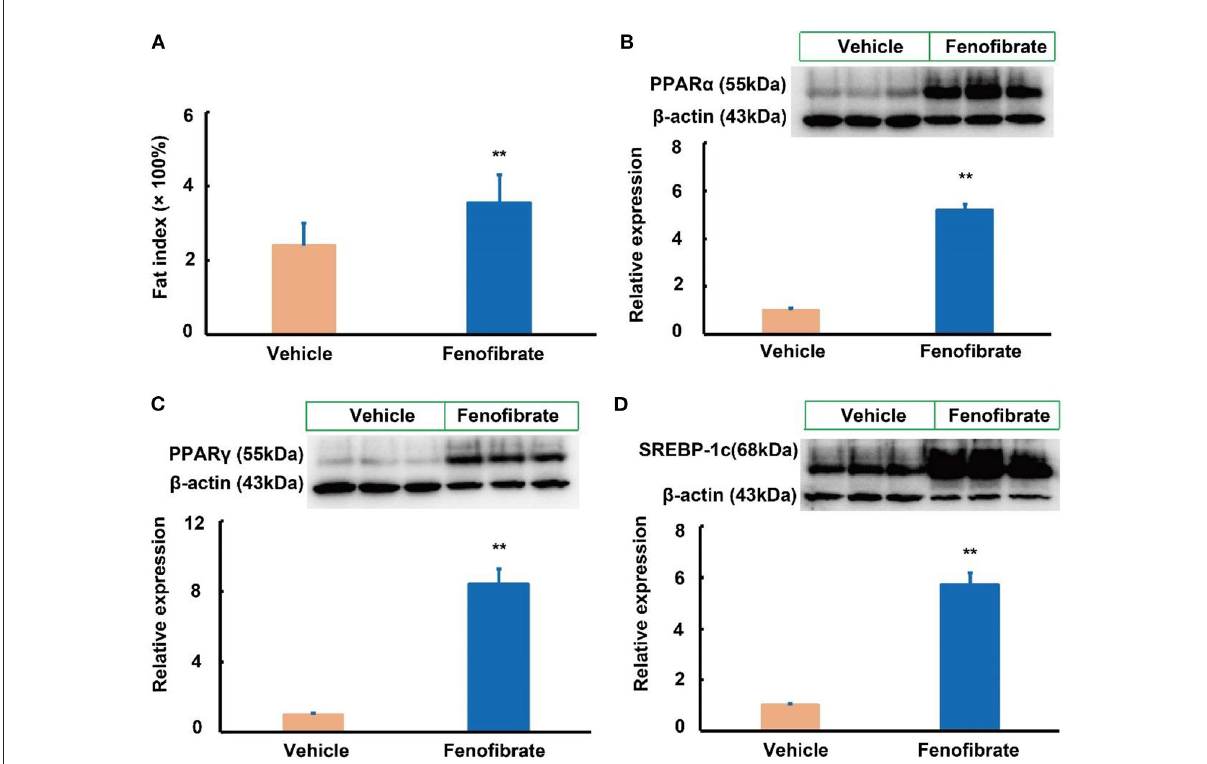
FIGURE5 Effect of fenofibrate on the fat index and expression of proteins involved in lipid metabolism in the white adipose of the ob/ob mice ( n = 6 unless otherwise specialized). (A) fat index was calculated according to the following formula: fat index = [(white adipose weight × 100%) ÷ body weight] ( n = 7 for the Vehicle group and n = 8 for the Fenofibrate group). Protein expression and densitometric quantification (B) peroxisome proliferator activated receptor (PPAR) α ; (C) PPAR γ ; (D) sterol regulatory element binding protein (SREBP)-1c. Data were expressed as mean ± SD, and the statistical analysis was performed by Student- t -test. ** means significantly different at p < 0.01 vs. Vehicle group. Vehicle: mice were treated with 0.5mL of water by gavage for 13 weeks; Fenofibrate: mice were treated with 0.5mL of fenofibrate suspension liquid at the dose of 20 mg/kg/d by gavage for 13